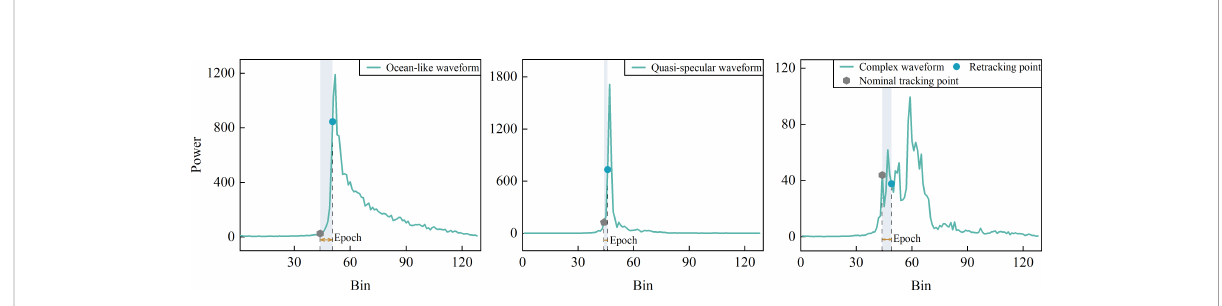
FIGURE 4 Correction results of Sentinel-3 coastal waveforms using TR_ALES+ retracker.